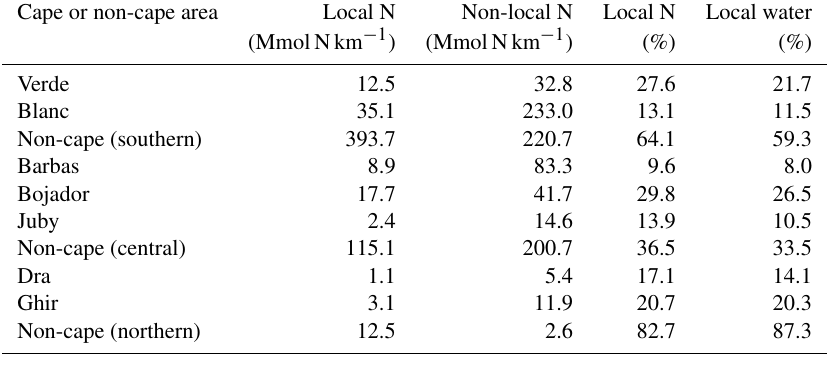
Table 2. The first two columns show the daily contribution of local and non-local upwelling to nitrogen that leaves the coastal region at each cape (in MmolNkm − 1 ) perkm of coastal length. The last two columns show the contribution of local upwelling (in %) to total nitrogen and water exported at each cape or non-cape coast.